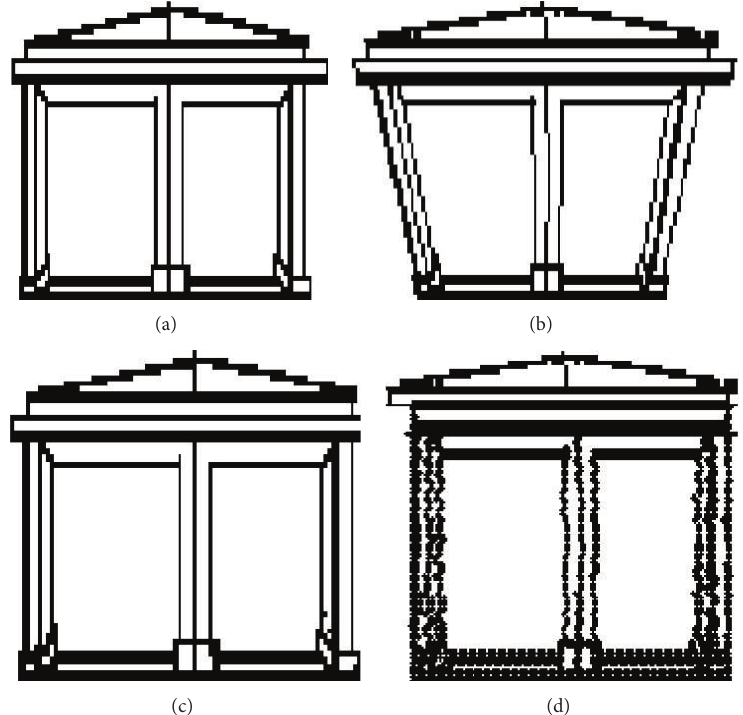
Figure 11: Experiment 2: nonlinear harmonic and its inverse for a circle